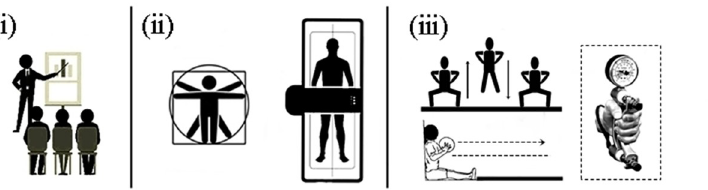
Fig 1. Study design—illustration of the moments and procedures used in the research. (i) Study’s explanation and Ethical consent. (ii) Day 1—Evaluation of body composition. (iii) Day 2 –Neuromuscular evaluation: muscle power (upper and lower limbs); and the peak of isometric strength (upper